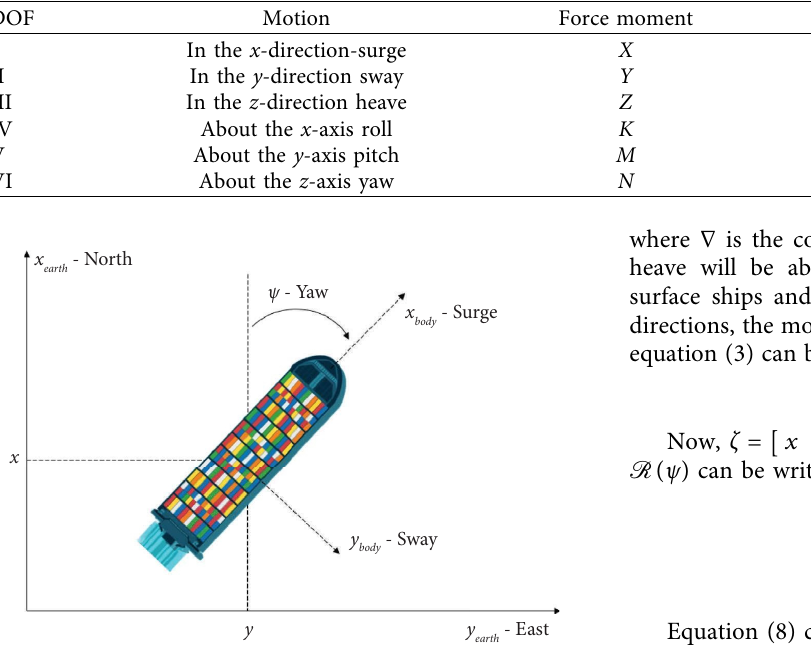
Table 1: Notations for marine vehicle.